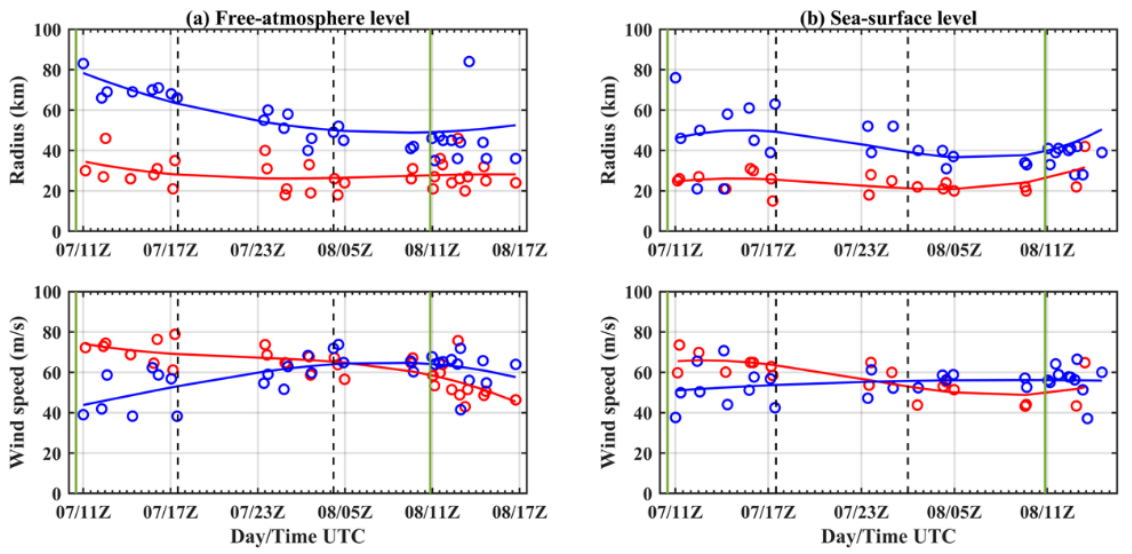
Figure 9. The same as Figure 6 but for the ERC04 event. The green vertical lines depict the SAR acquisition time.